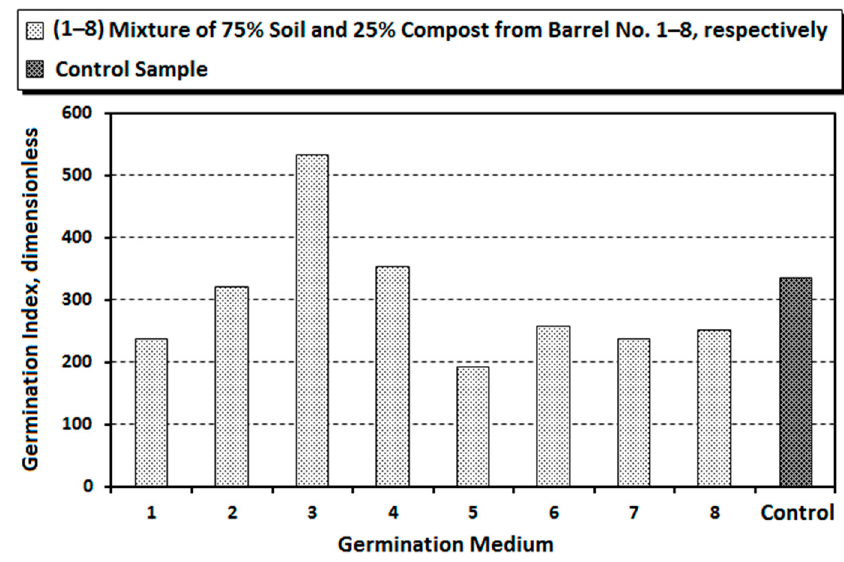
Figure 8. Germination index of each germination medium calculated according to Kader [40] . Table 3. Germination parameters of each tested germination medium.